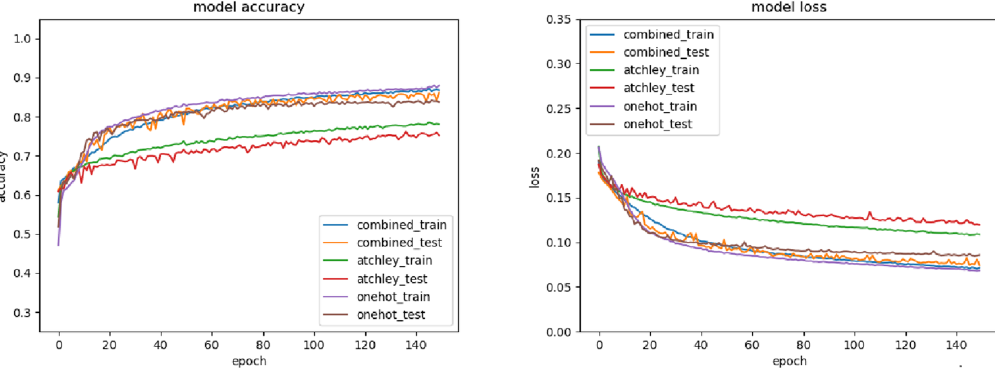
Figure 3. Accuracy and loss curves for one-hot encoding, Atchley 5-factor encoding, and combined encoding